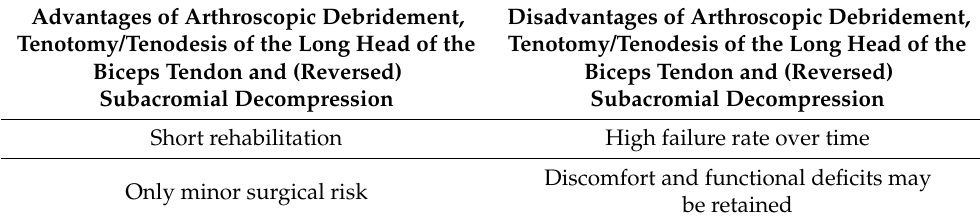
Table 2. Advantages and disadvantages of arthroscopic debridement, tenotomy/tenodesis of the long head of the biceps tendon and (reversed) subacromial